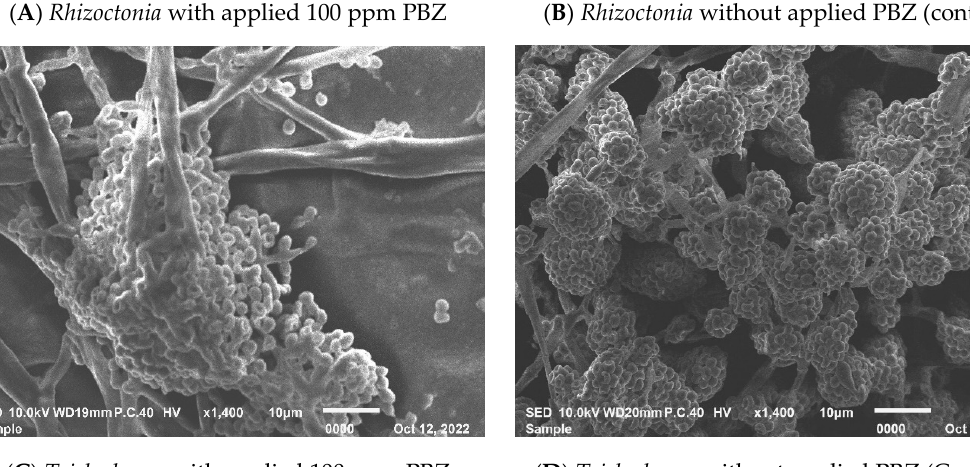
Figure 2. Scanning electron microscope (SEM) examination of Rhizoctonia solani including with ap- plied PBZ ( A ) and without applied PBZ ( B ) and Trichoderma harzianum in case of applied PBZ ( C ) and control ( D ) on PDA media. This medium was treated with PBZ application at dose of 100 ppm ( A , C ).